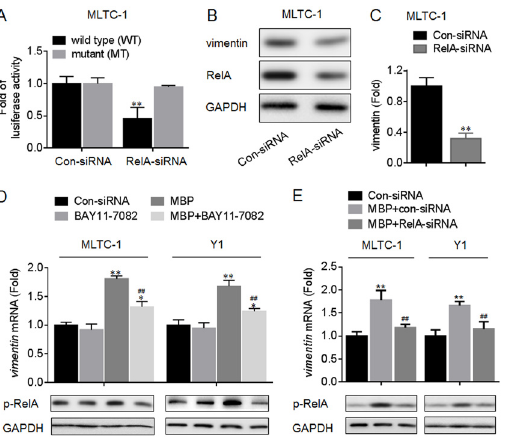
Fig 8. Functions of NF- κ B in the transcriptional activation of vimentin. (A) MLTC-1 cells were co- transfected by Con-siRNA or RelA-siRNA plus pGL3-vimentin-Luc construct (wild type, WT; or mutant, MT) for 12 h. Luciferase reporter assay analysis of the effects of NF- κ B on the transcriptional activity in vimentin promoter. (B and C) MLTC-1 cells were transfected by Con-siRNA or RelA-siRNA for 12 h. (B) Western blots analysis and (C)relative protein levels of vimentin. ** p < 0.01 compared with cells transfected by Con-siRNA. (D) After MLTC-1 and Y1 cells were pre-treated by 0 or 10 μ M BAY11-7082 for 12 h, they were exposed to 0 or 1000 nM MBP for 24 h. (D, top) qRT-PCR analysis in triplicate of vimentin mRNA, * p < 0.05 and ** p < 0.01 compared with medium control cells; ## p < 0.01 compared with cells exposed to MBP alone. (D, bottom) Western blots analysis of the expression of p-RelA. (E) After MLTC-1 and Y1 cells were pre-transfected by Con-siRNA or RelA-siRNA for 12 h, they were exposed to 1000 nM MBP for 24 h. (E, top) qRT-PCR analysis in triplicate of vimentin mRNA, ** p < 0.01 compared with medium control cells; ## p < 0.01 compared with cells exposed to MBP plus